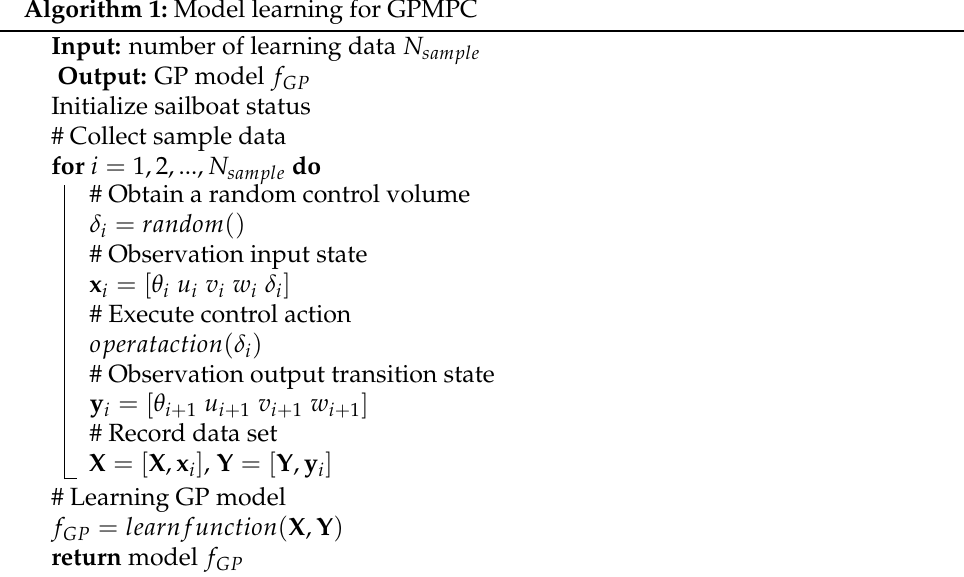
Figure 3. The effect of weight adaptation term in the control process. Algorithm 1: Model learning for